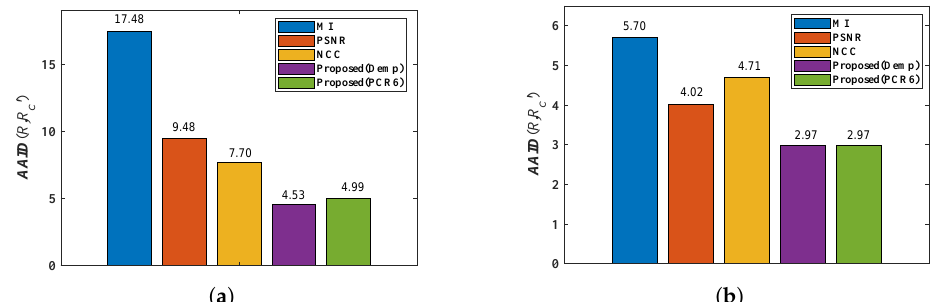
Figure 18. AAID evaluations of registration results for Concord image pair and Hestain image pair. ( a ) Concord. ( b ) Hestain.